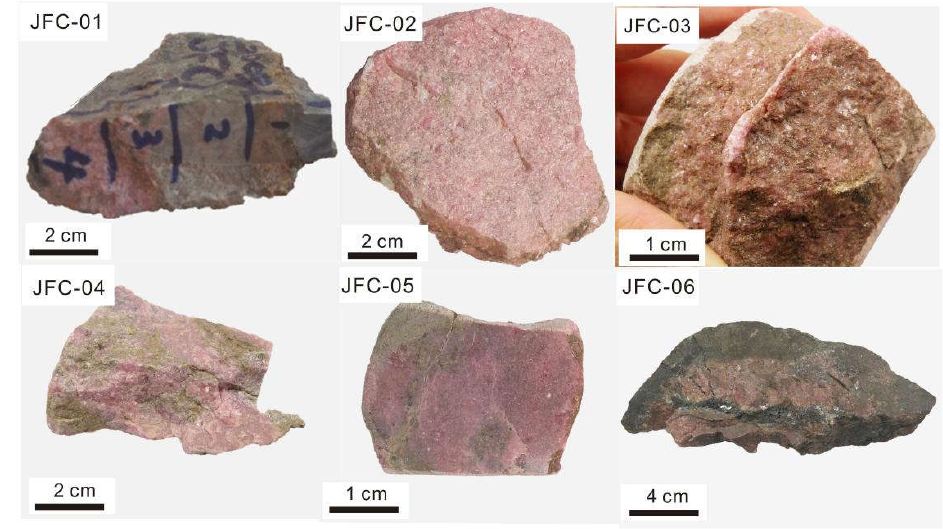
Figure 2. Photos of JingFenCui rough